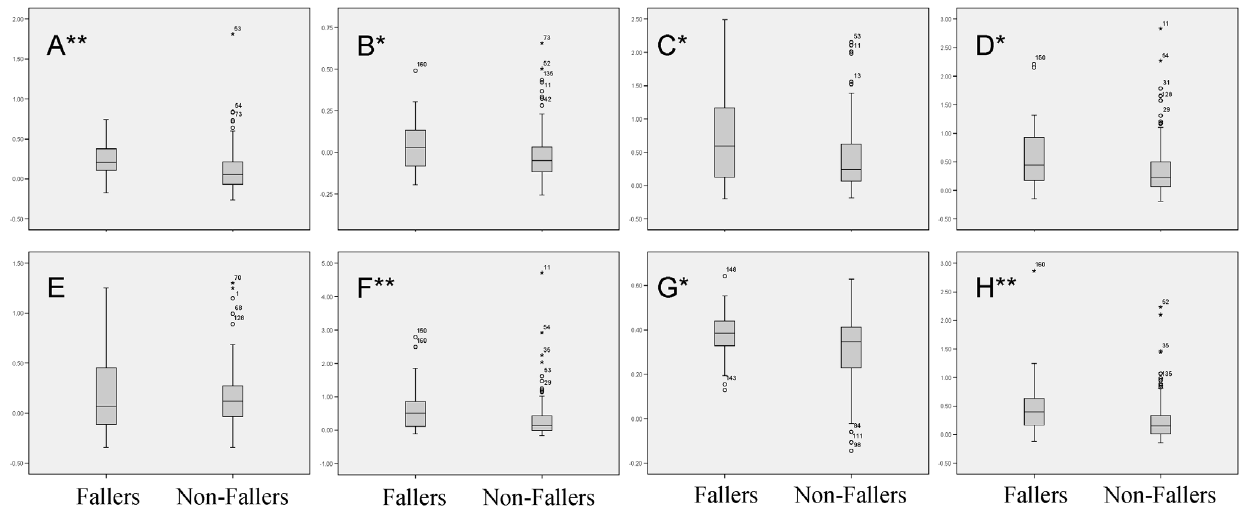
Figure 3. Box plots of Z-scores for maximal COP displacement (A), RMS of COP displacement (B), Maximal COP Velocity (C), RMS of COP Velocity (D), Median Frequency (E), Short Term Diffusion Coefficient (F), Long Term Scaling Exponent (G), and Critical Displacement (H). All measures but median frequency were significantly greater in fallers than non-fallers. The non-faller group had a number of outliers which were not excluded from data analysis. *p , 0.05, **p ,